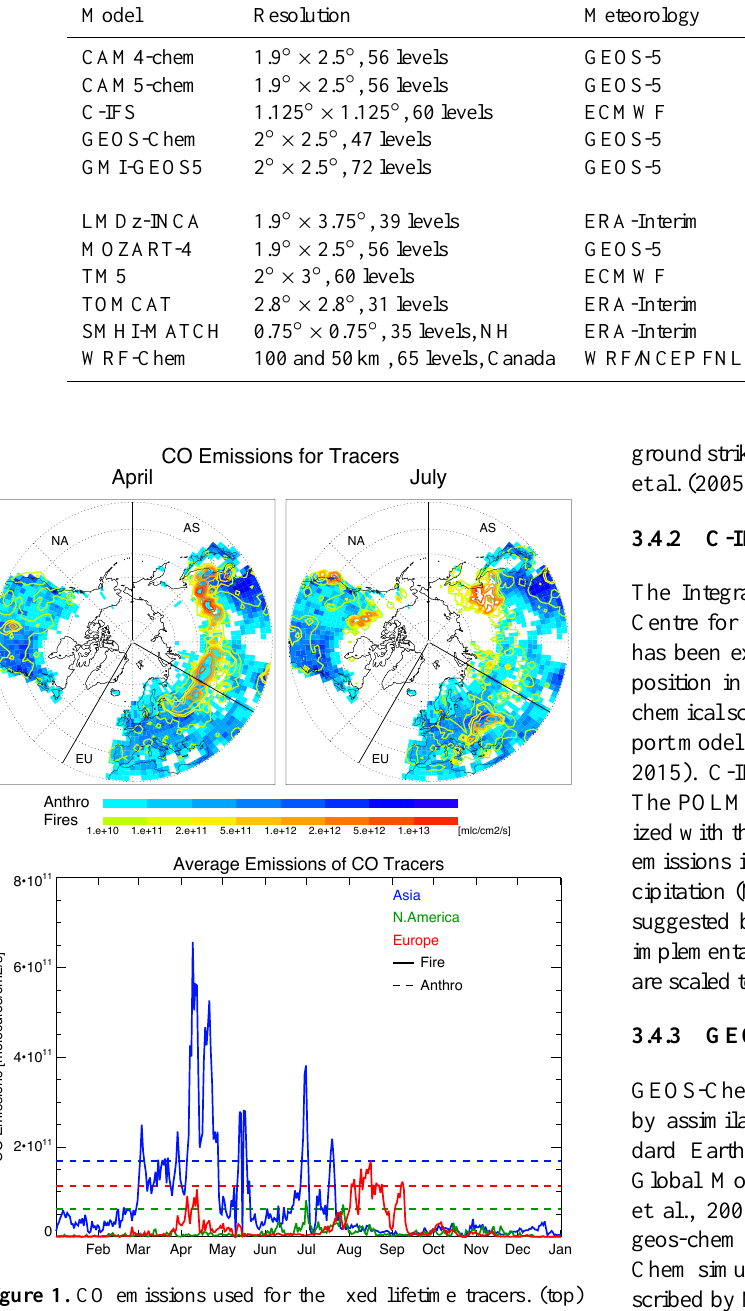
Figure 1. CO emissions used for the fixed lifetime tracers. (top) Map of anthropogenic (blue boxes) and fire emissions (yellow-red contours) for April and July monthly averages. (bottom) Time series of daily fire and anthropogenic emissions averaged over each tracer region. Anthropogenic emissions have no temporal